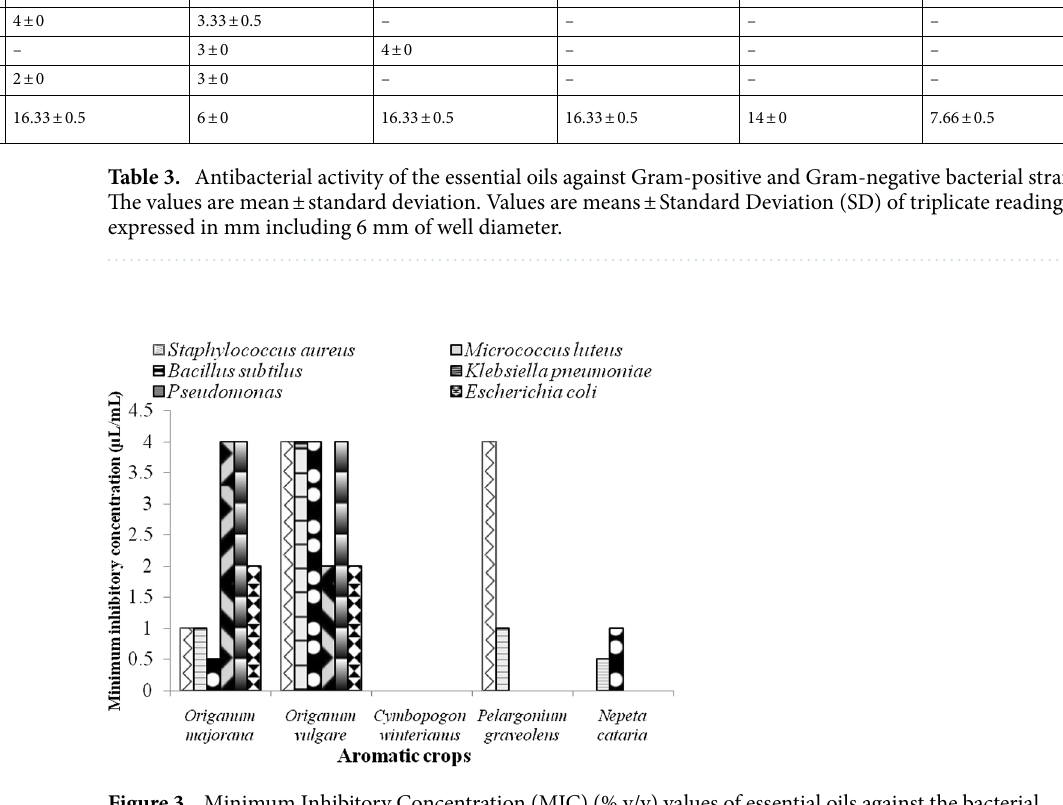
Figure 3. Minimum Inhibitory Concentration (MIC) (% v/v) values of essential oils against the bacterial strains. The experiment was repeated in triplicate on three separate